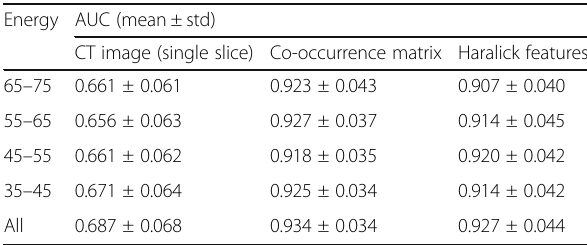
Table 5 Results of the difference image